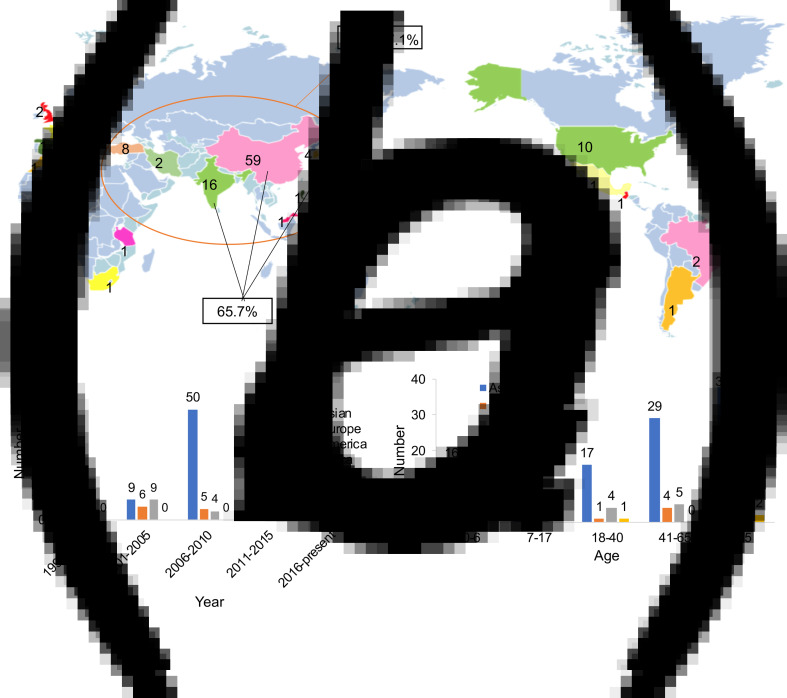
Basic statistical features of 140 cases of T. asahii infection. (a) Regional distribution. (b) Temporal distribution of 140 cases (year). (c) Age distribution.